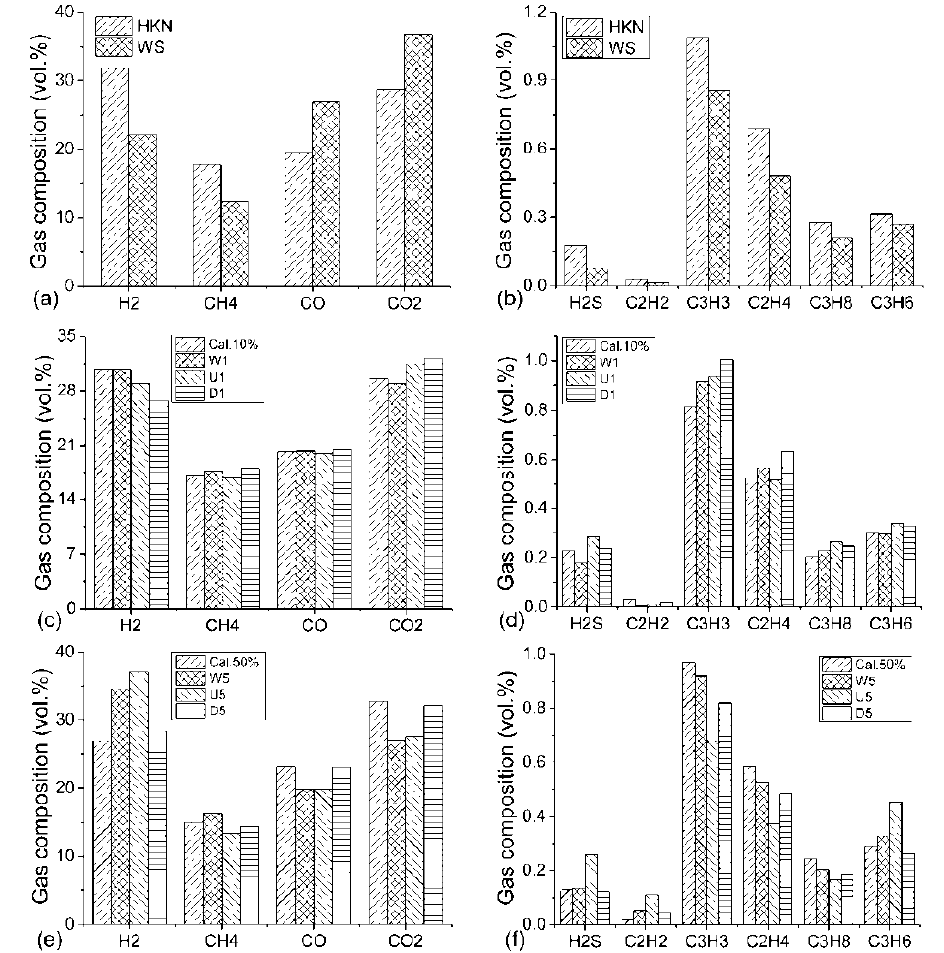
Figure 5. Experimental and calculated gas composition during co-pyrolysis of WS and HKN in LPA reactor, ( a ) major components from single fuel, ( b ) minor components from single fuel, ( c ) major components from 10 wt.% blends, ( d ) minor components from 10 wt.% blends, ( e ) major components from 50 wt.% blends, ( f ) minor components from 50 wt.% blends.